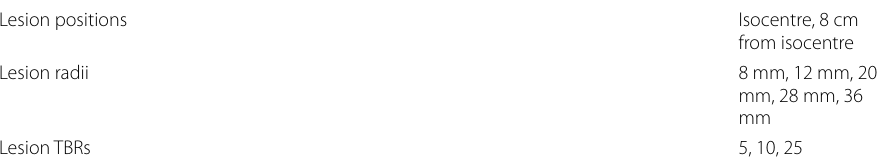
Table 1 A summary of different lesions examined using the uniform elliptical phantom Lesion